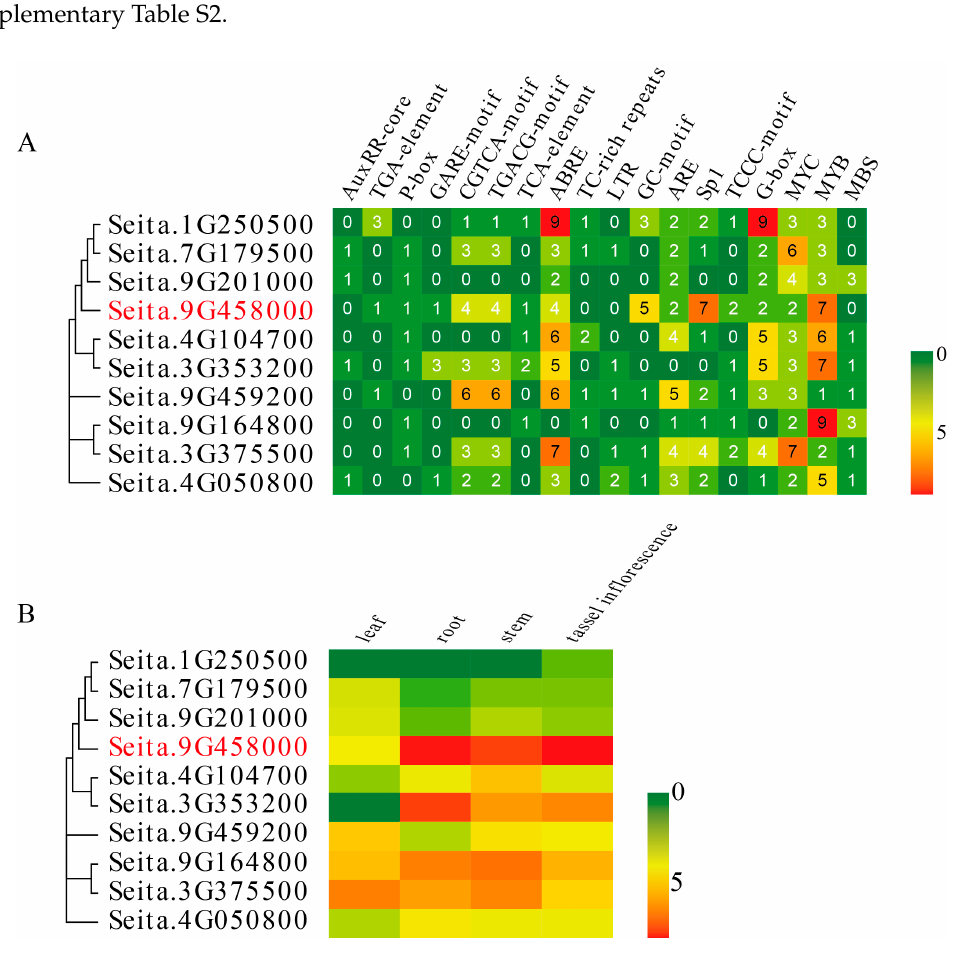
Figure 3. Promoter analysis of foxtail millet LIM genes and Tissue-specific expression profiles. ( A ) Promoter analysis of foxtail millet LIM genes. The cis -acting elements in the promoter regions were obtained from the PlantCARE database. Hormone response elements: AuxRR-core, TGA-element, P-box, GARE-motif, CGTCA-motif, TGACG-motif, TCA-element, ABRE; abiotic stress elements: TC-rich repeats, LTR, GC-motif, ARE, Sp1, TCCC-motif, G-box, MYC, MYB, MBS. Different colors represent the number of cis -acting elements within the promoter, with red indicating a higher number and green indicating a lower number. ( B ) Tissue-specific expression data were derived from published Illumina RNA-seq data. Data for roots, stems, leaves and tassel inflorescences were downloaded from the European Nucleotide Archive database [47,48]. The fragments per kilobase of exon model per million mapped reads (FPKM) values were log 2 transformed, and a heat map was drawn using Evolview (http://www.evolgenius.info/evolview, accessed date: 7 September 2018). Different colors represent the level of expression, where red indicates a high level of gene expression, and green represents a low level of gene expression. The SiWLIM2b gene is marked in